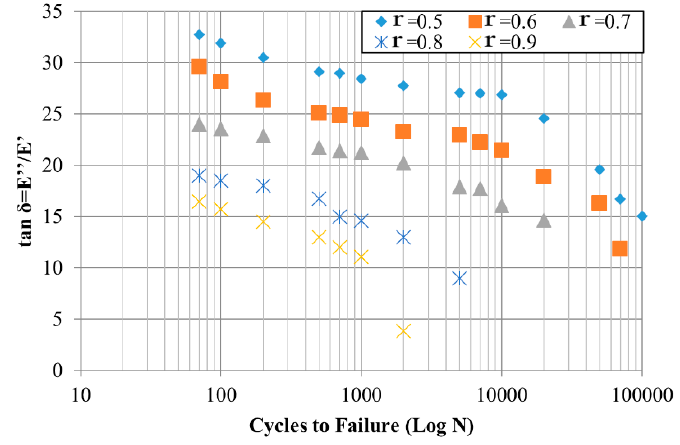
Figure 11. Tan ( δ ) vs. Log (N) graph for the 6AL10b specimen.